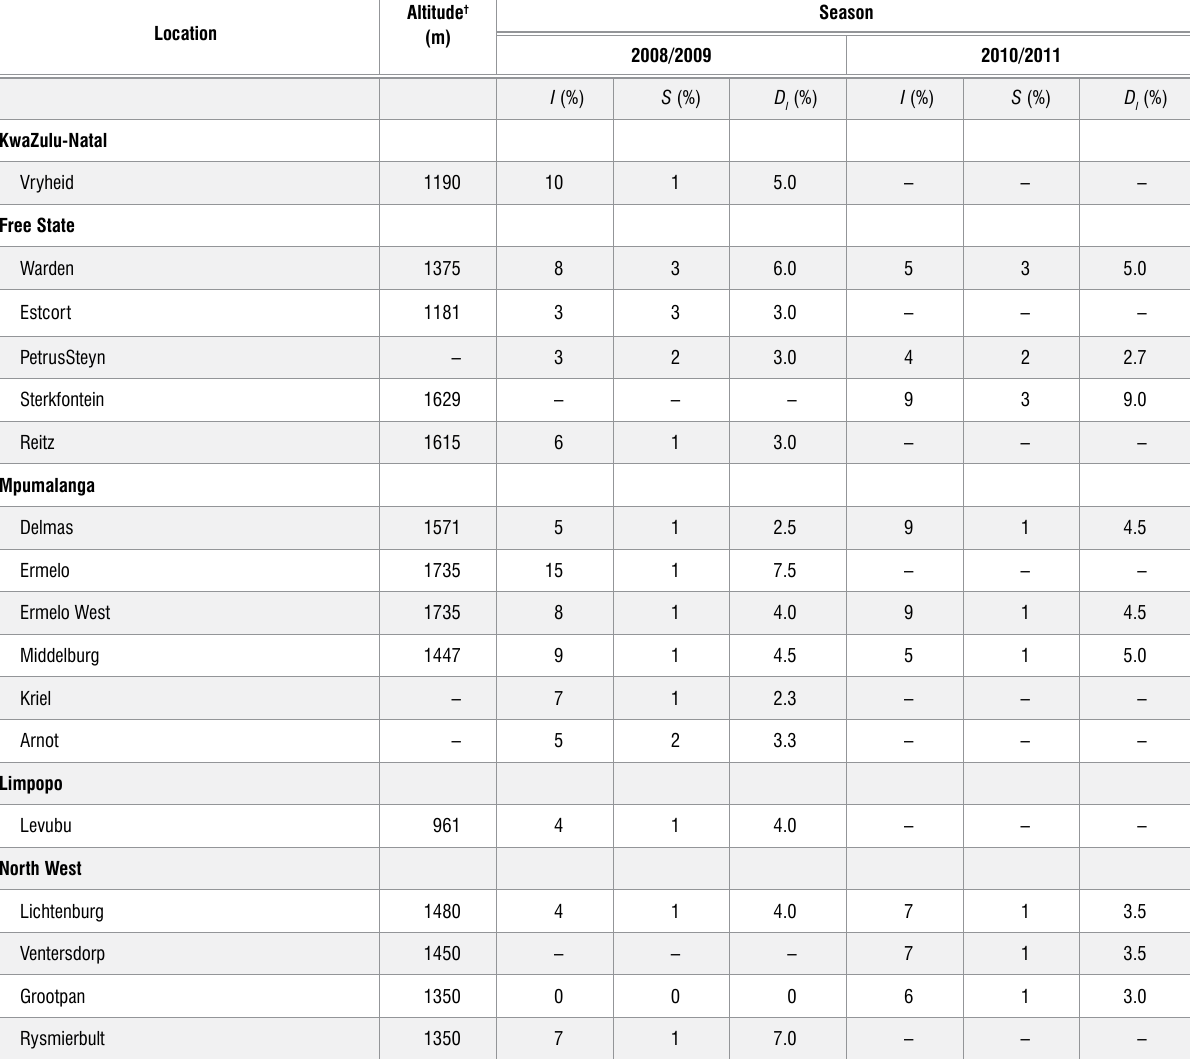
Occurrence of bacterial brown spot in dry bean commercial fields of South